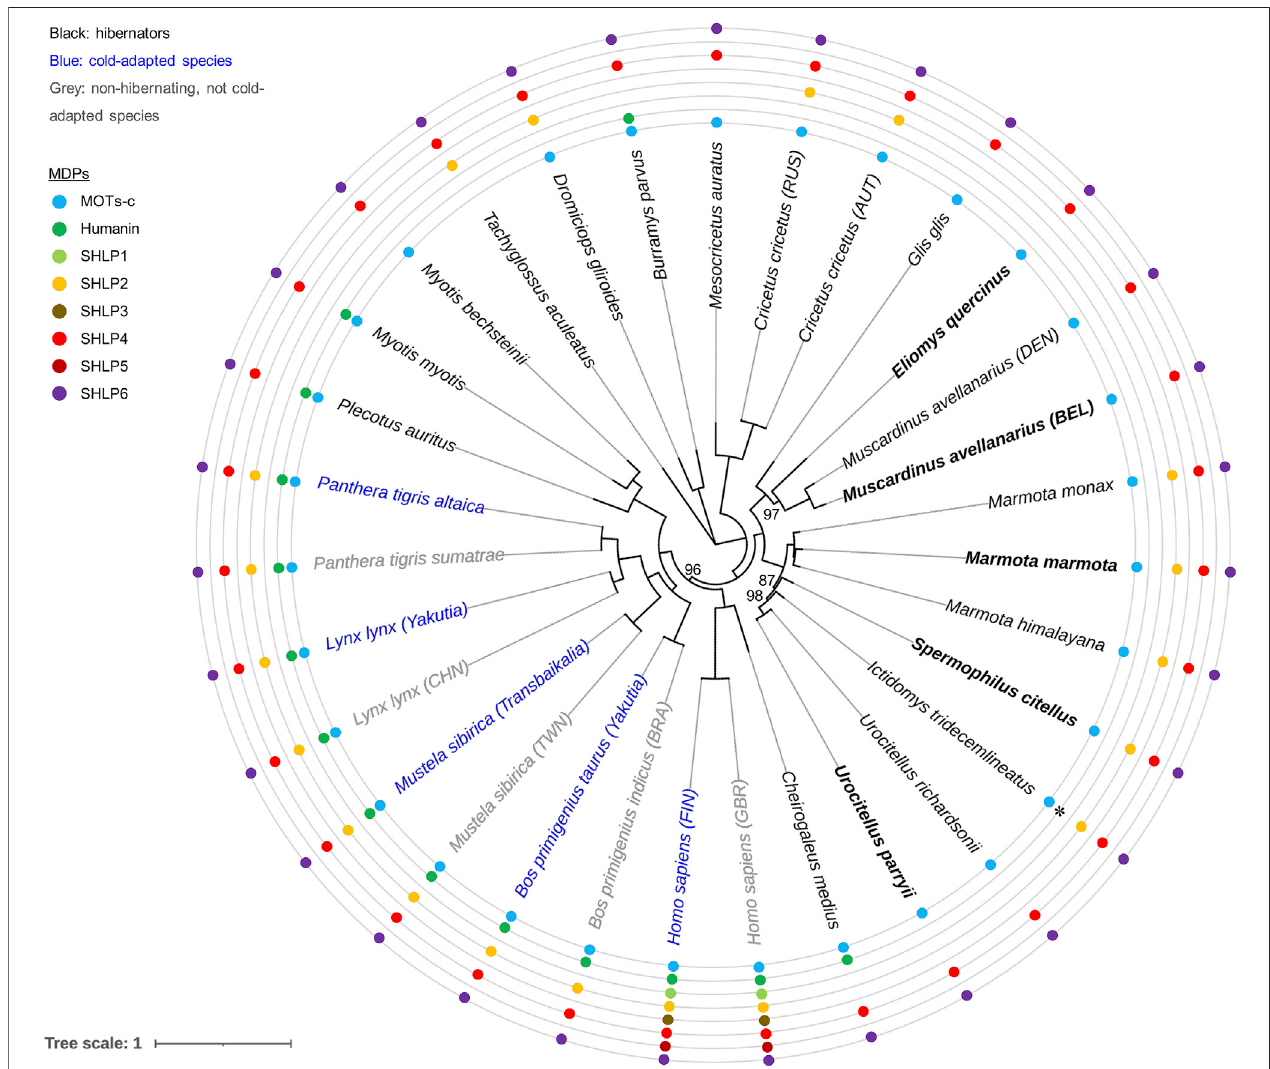
FIGURE 4 | Inference of evolutionary and mtDNA-based relationships among our fi ve hibernator rodent models. Summary on predicted MDPs and ML phylogenetic reconstruction using NCR-depleted mitogenomes without partitioning. Rodent hibernators used for extending mitogenome enrichment based on single long-range PCR are highlighted in bold. Cricetus cricetus , a facultative hibernator (Weinhold, 2015), is represented by a Russian (RUS) haplotype (GenBank: NC_037,888.1 or MF034880 (Ding et al., 2020))originatingfrom Nalchik(republic Kabardino-Balkariya,southwesternRussia),and byanAustrian (AUT)haplotype determined by genome skimming within this project (GenBank: MF405145.2; sequence homology: 98.7%). Note that a second mitogenome was also available for the hazel dormouse (Danish (DEN) haplotype, mtDNA divergence: 9.1%). Bootstrap support measures were calculated from 1,000 tree replicates; only values below 100% are depicted. GenBank accession numbers of the presented mitogenomes are provided in Supplementary Table S4 . Pairs of subspecies, intraspecies cohorts or haplogroups were selected to illustrate the different degrees of adaptation to cold temperatures (cattle, Eurasian lynx, human , Siberian weasel and tiger). Prediction of MDPs (speci fi ed by coloured circles) was restricted to the rule that intra-mitochondrial transcription is combined with cytoplasmic translation according to the standard (nuclear)geneticcode(Cobbetal.,2016;Leeetal.,2016).EightaminoacidswereappliedasanarbitraryminimumforsORFsize.Theasteriskdepictstheonlydeviation from this general rule — the experimental proof of humanin translation according to the vertebrate mitochondrial code in case of the thirteen-lined ground squirrel (Szereszewski and Storey, 2019). We note that this illustration neither speci fi es length and sequence differences of MDPs nor issues expression of MDPs from nuDNA that cannot be ruled out in principle. Names of countries are presented as three-letter country codes of the International Organization for Standardization: Brazil (BRA), China (CHN), Finland (FIN), Great Britain (GBR), Taiwan (TWN). The nucleotide alignment used for phylogenetic analysis is available as Supplementary File 1 . Similar bootstrapsupportwasobtainedbypartitioningtheNCR-depletedmitogenomesequencesintothreesetsofcodingsequence(mRNA, rRNAandtRNAgenes;valuesof 85 – 99 ( n (cid:2) 5) and 100).